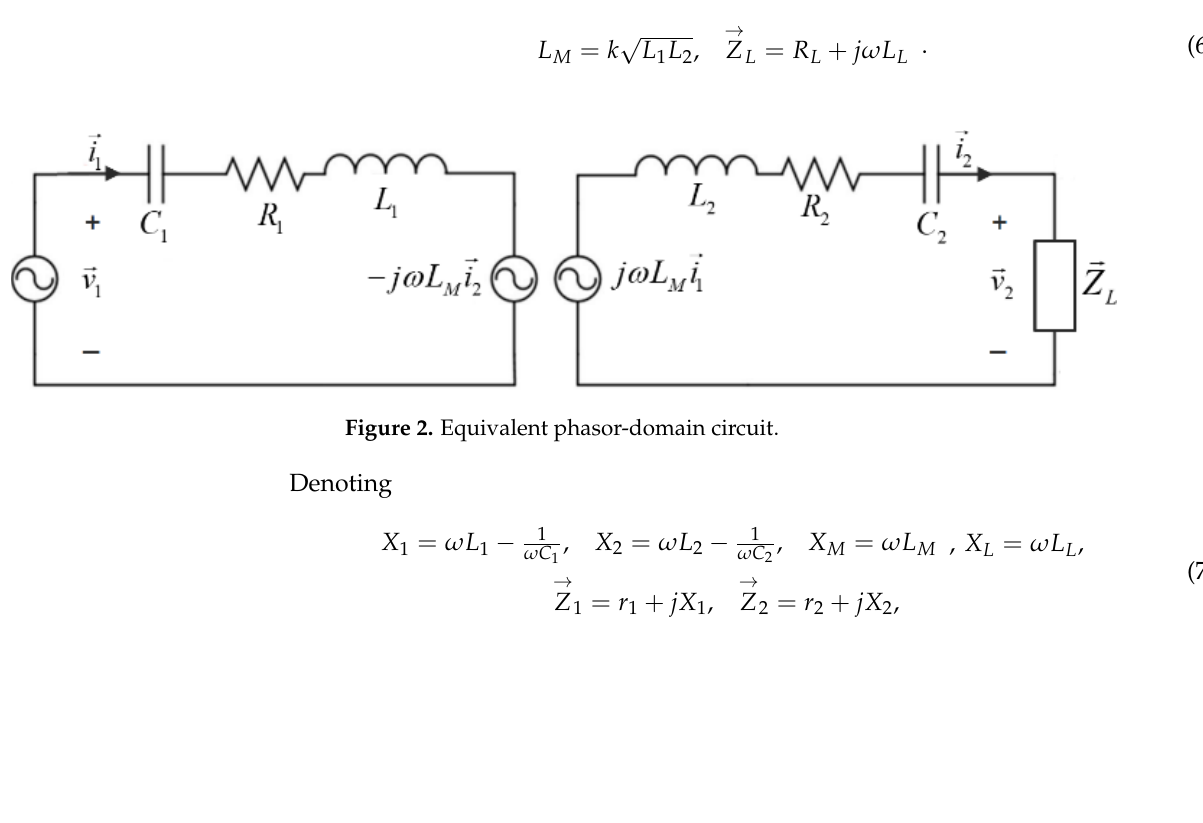
Figure 2. Equivalent phasor-domain circuit.